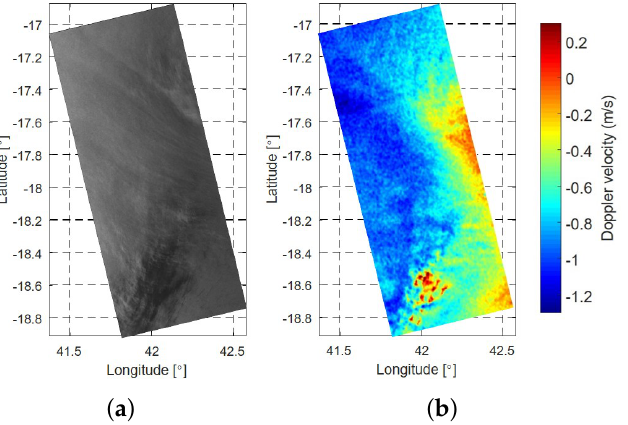
Figure 4. Sentinel-1 SAR ( a ) amplitude image and ( b ) radial Doppler